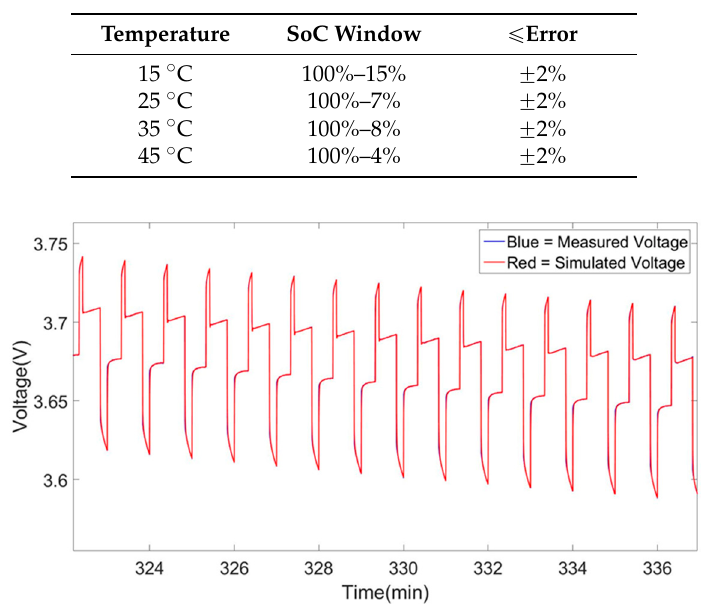
Table 8. Results of the models where the SoC window is less than the proposed error.